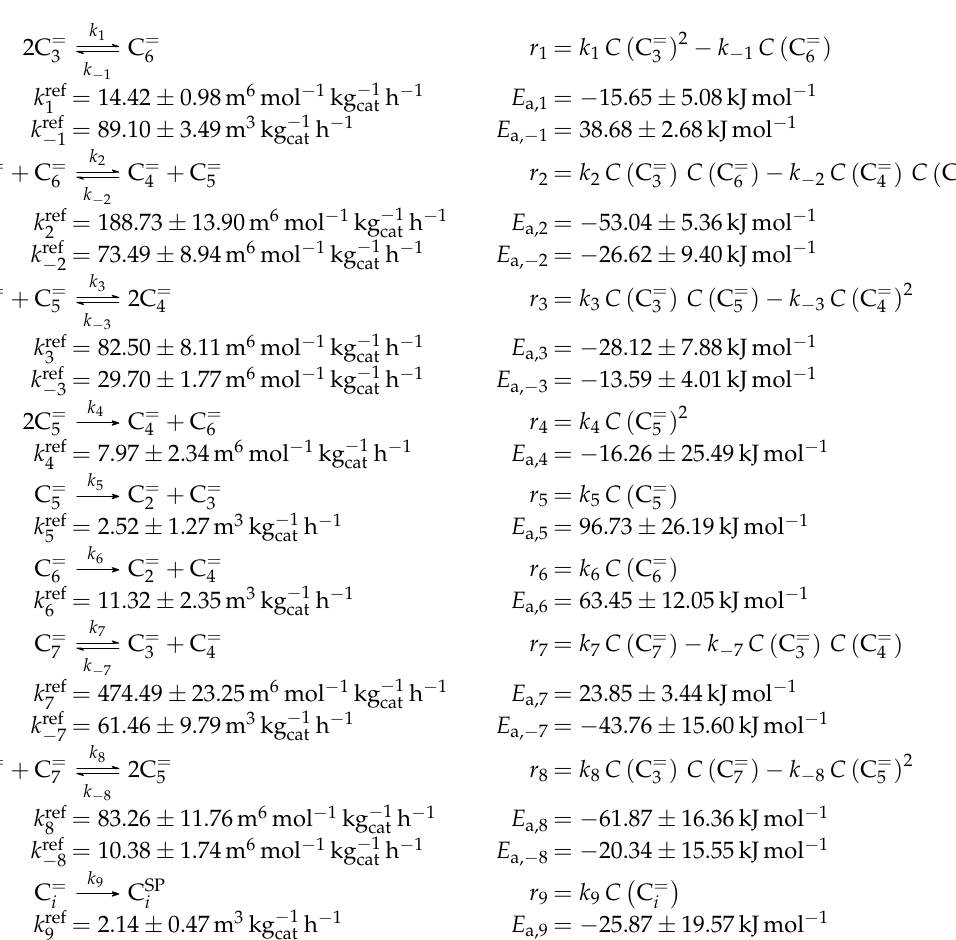
Scheme 6. Reaction network, rate equations and estimated parameters for the model by Ying et al. [236] with i ranging from 3 to